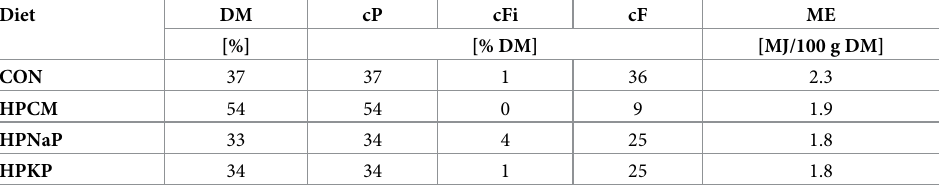
Table 1. Content of crude nutrients, and energy (ME) in the control diet (CON) and 3 high phosphorus diets, con- taining either poultry carcass meal (HPCM), NaH 2 PO 4 (HPNaP) or KH 2 PO 4 (HPKP) as a dietary source of